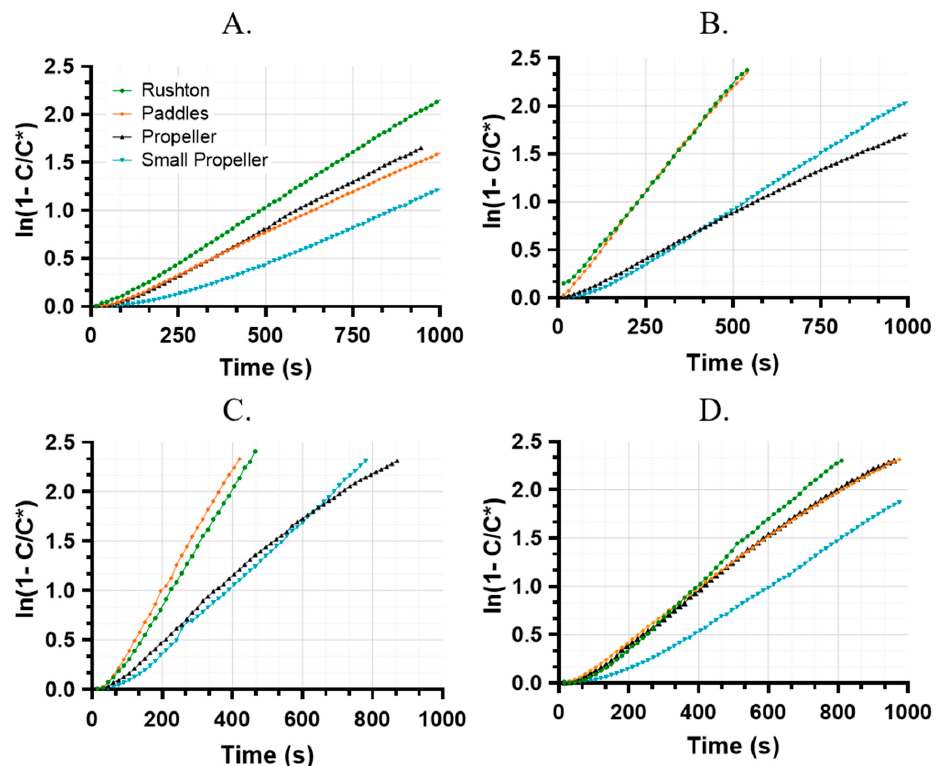
Figure A4. k L a determination for one agitation configuration: ( A ) 2.5 l min − 1 and 100 RPM; Figure A4. 𝑘 (cid:3013) 𝑎 determination for one agitation configuration: (A) 2.5 𝑙 𝑚𝑖𝑛 (cid:2879)(cid:2869) and 100 RPM; (B) 2.5 ( B ) 2.5 l min − 1 and 250 RPM; ( C ) 5 l min − 1 and 100 RPM; and ( D ) 5 l min − 1 and 250 RPM. 𝑙 𝑚𝑖𝑛 (cid:2879)(cid:2869) and 250 RPM; (C) 5 𝑙 𝑚𝑖𝑛 (cid:2879)(cid:2869) and 100 RPM; and (D) 5 𝑙 𝑚𝑖𝑛 (cid:2879)(cid:2869) and 250 RPM.